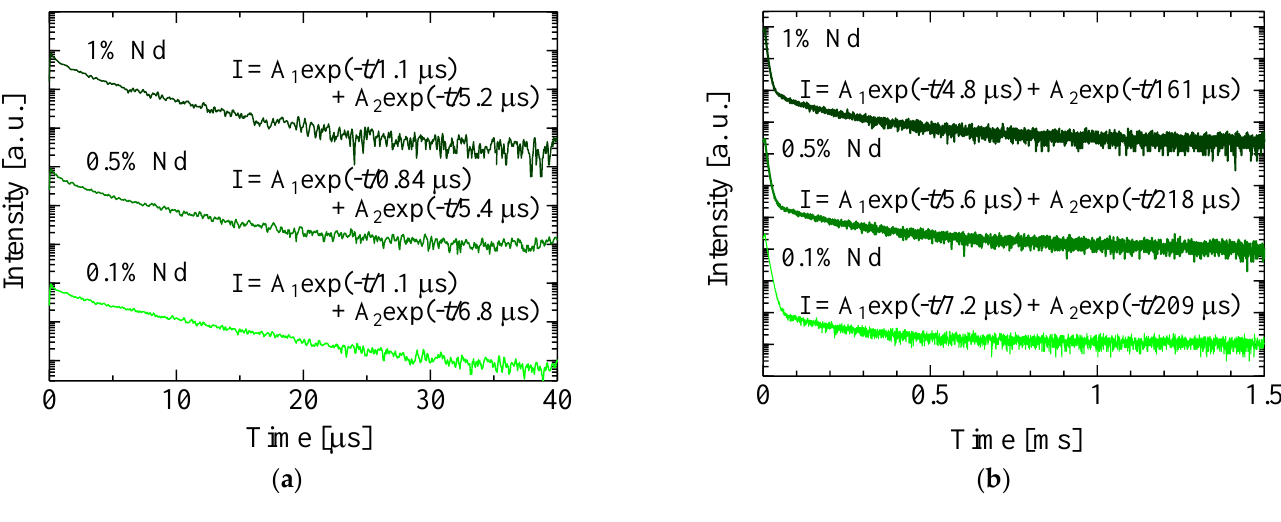
Figure 7. X-ray-induced scintillation decay curves of Nd-doped CaWO 4 monitored ( a ) UV – visible ranges and ( b ) visible – NIR ranges.